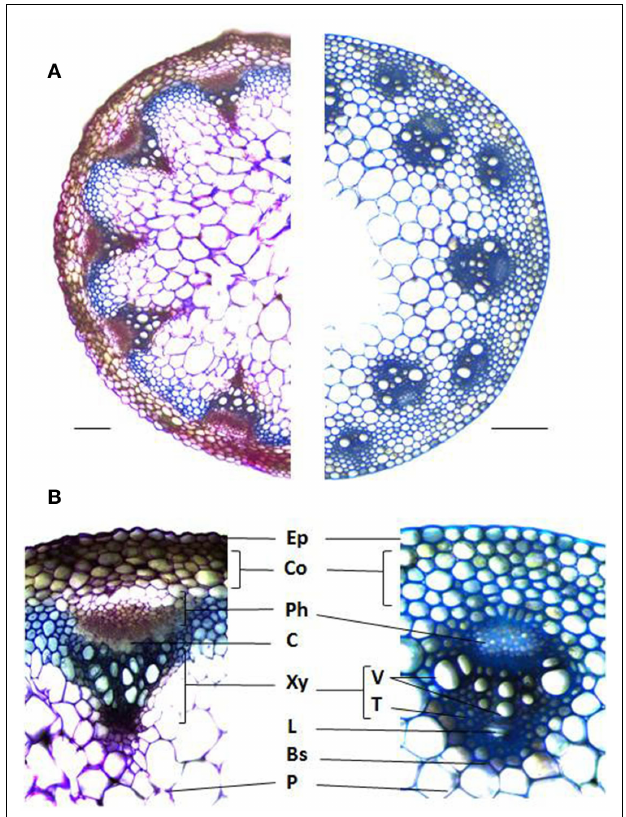
FIGURE 1 | Stem cross sections illustrating the different cell types and arrangements between dicots and monocots. (A) Arabidopsis thaliana (left) and Brachypodium distachyon (right) stained withToluidine blue. (B) Vascular bundle anatomy of A. thaliana (left) and B. distachyon (right). Ep, Epidermis; Co, Cortex; Ph, Phloem; C, Cambium; Xy, Xylem;V,Vessels;T, Tracheads; L, Lacuna; Bs, Bundle Sheath; P, Pith. Bars =